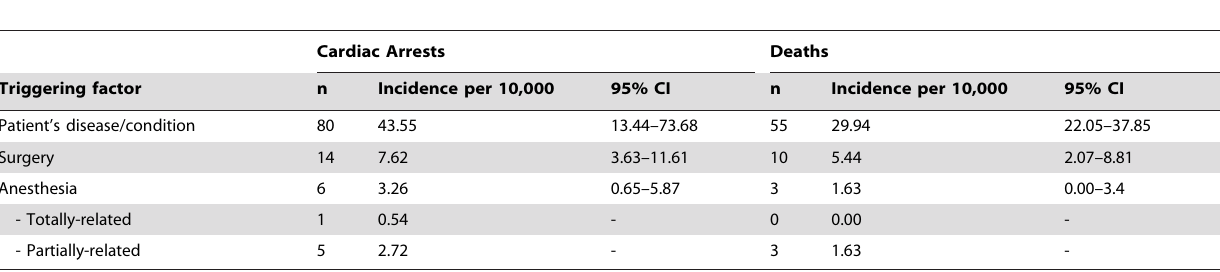
Table 3. Intraoperative cardiac arrest and death incidences among 18,367 anesthetics in older patients according to triggering factor.